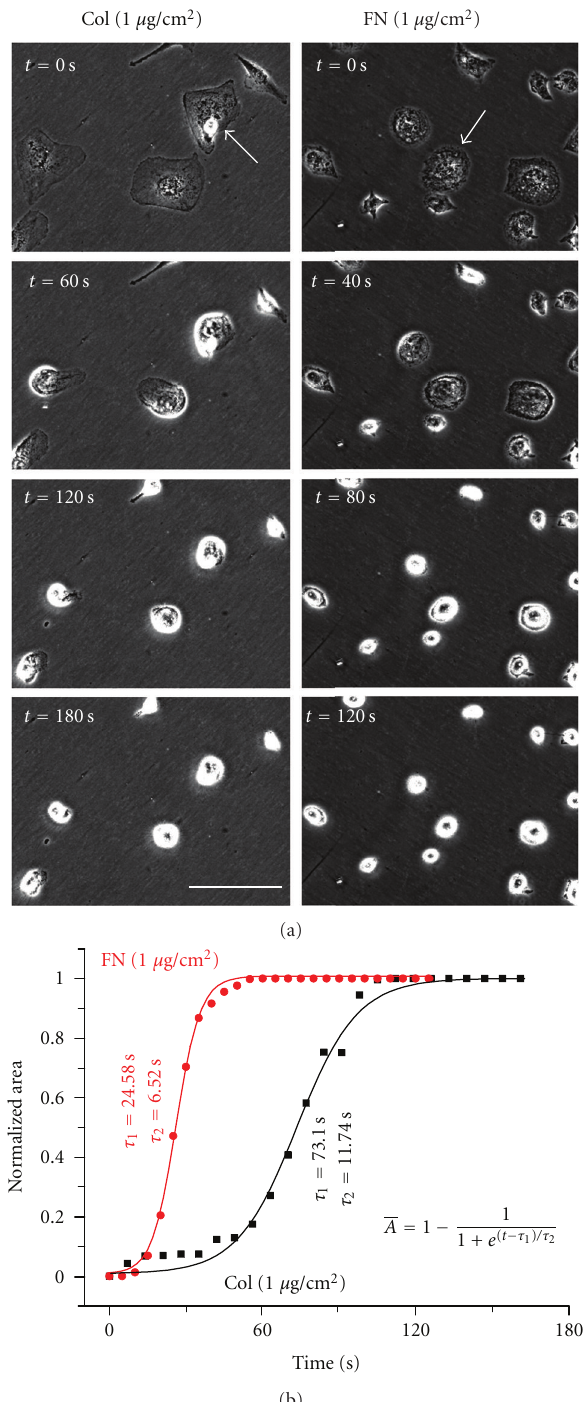
Figure 4: Deadhesion dynamics of MDA-MB-231 cells on collagen- and fibronectin-coated surfaces at a theoretical density of 1 μ g/cm 2 . (a) Media was removed and cells were washed with PBS prior to incubation with warm trypsin. Cells were imaged immediately upon addition of trypsin every 5 or 6 seconds at low magnification (20x) till cells rounded up but remained attached to the substrate. Scale bar = 100 μ m. (b) Deadhesion of the cells indicated by arrows was quantified by plotting normalized area as a function of time. The normalized data were fit to a Boltzmann equation to obtain the time constants τ 1 and τ 2 , as indicated next to the fits